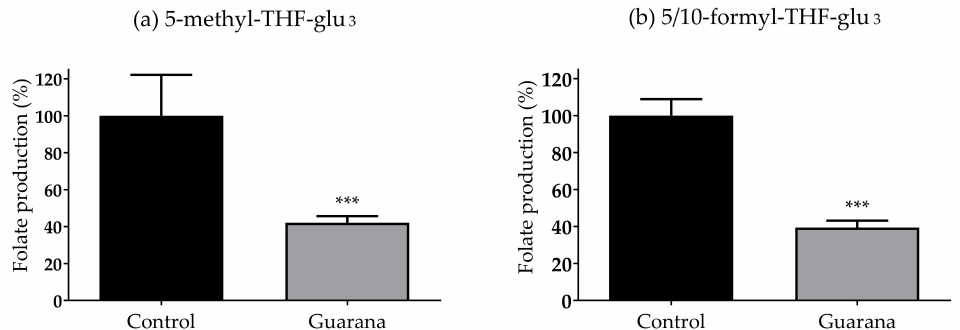
Figure 4. Guarana (500 µ g/mL) effects on the E. coli production of two folate forms, ( a ) 5-methyl THF- glu 3 (5-CH 3 -H 4 PteGlu 3 ) and ( b ) 5/10-formyl THF-glu 3 (10-CHO-H 4 PteGlu 3 ). Data are presented as the mean and SD of the percentage of folate production of five replicates (*** p <